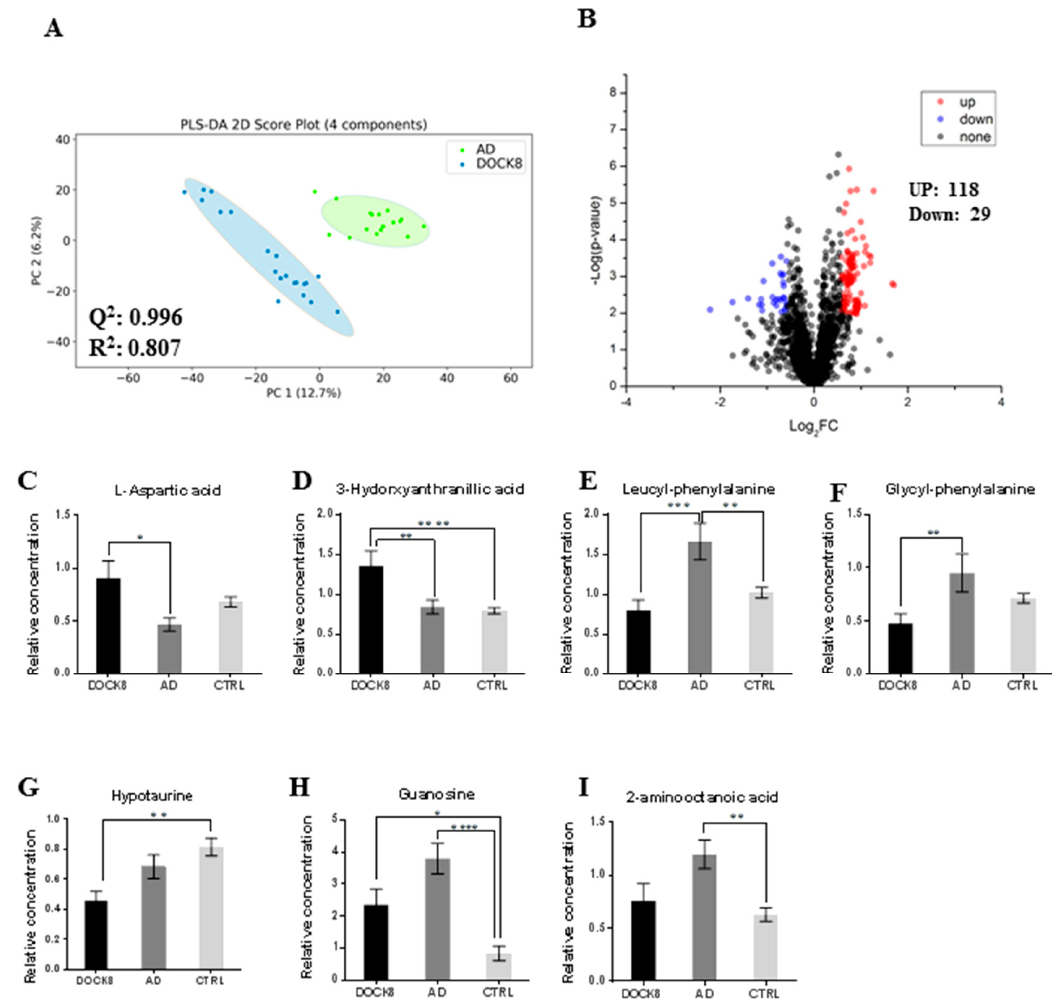
Figure3. PositivelyidentifiedserummetabolitesinDOCK8-deficientpatientsvs. ADvs. Ctrls. ( A )PLS-DA score plot for binary comparison between DOCK8-deficient patients and AD, with a calculated space Q 2 = 0.996 and R 2 = 0.807, four latent variables were used as they have the highest cross-validation Q 2 value. ( B ) Volcano plot analysis with fold change > 1.5 (up-regulated = 118) and < 0.67 (down-regulated = 29), a total of seven metabolites were positively identified. ( C ) L-Aspartic acid is up-regulated in DOCK8-deficient patients compared with AD patients. ( D ) leucyl-phenylalanine and glycyl-phenylalanine are up-regulated in AD patients compared with patients compared with Ctrl. ( H ) Guanosine is up-regulated in DOCK8-deficient and AD patients, while 2-aminooctanoic acid is up-regulated in AD patients only. ( I ) For paired analysis, a